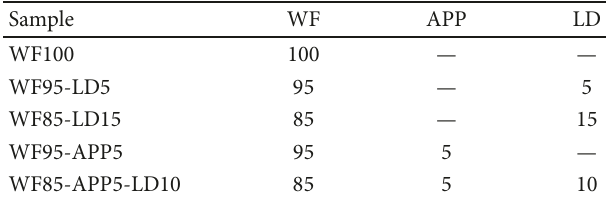
Table 1: Particleboard codes and compositions